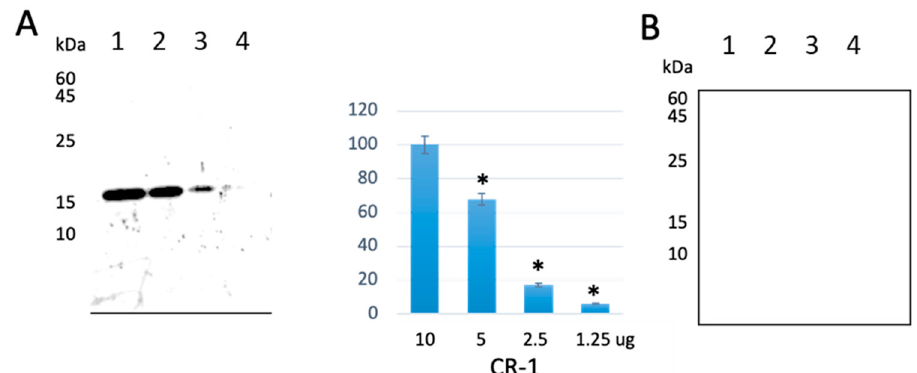
Figure 6. Western blotting of CR-1 antigen detected by anti-CR-1 Ab: ( A ) Reducing condition (left) and densitometric analysis of the band detected on the membrane (right). Each bar is the mean ± SD from three independent experiments. * p < 0.05. ( B ) Non-reducing condition. Lane 1, 10 µg; Lane 2, 5 µg; Lane 3, 2.5 µg; Lane 4, 1.25 µg. The primary antibody was anti-CR-1 Ab Clone 35 (500 ng/mL), while the secondary antibody was anti-human IgG HRP (dilution 1:5000).